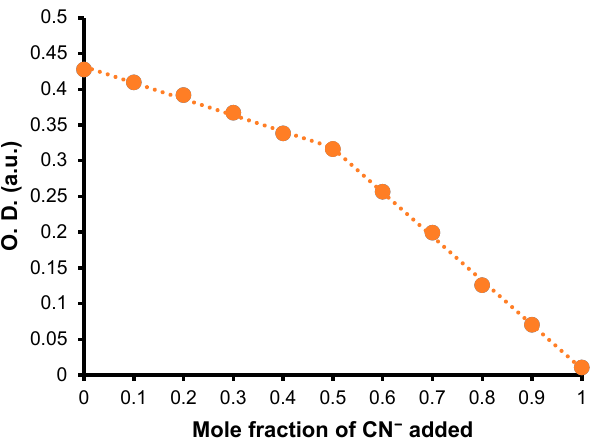
Figure 11. UV–Vis Job-plot for 8.CN − , [ 8 ] 0 + [CN − ] 0 = ca 1.40 × 10 − 5 M.